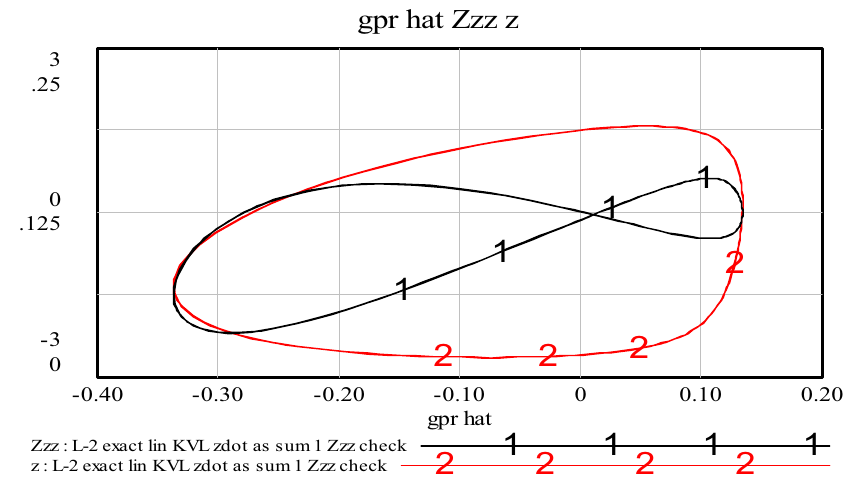
Fig. 15 Growth rate of profit rate ˆ R vs partial derivative of net change of z with respect to z (1) and vs capital accumulation rate z (2) for the first limit cycle in L-2, years